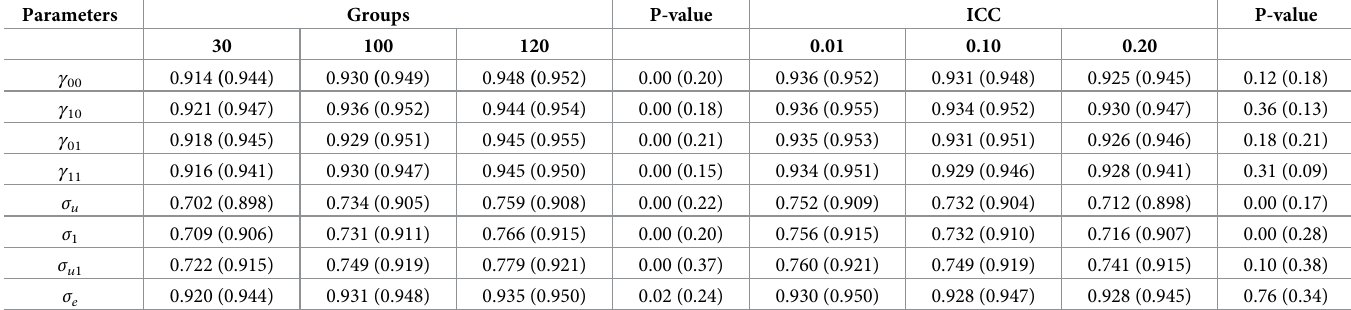
Table 6. Impact of groups ICC on estimates 95% coverage probability for lognormal distribution data (First = REML estimation procedure, Second = Percentile bootstrap estimates are enclosed in parenthesis). Parameters